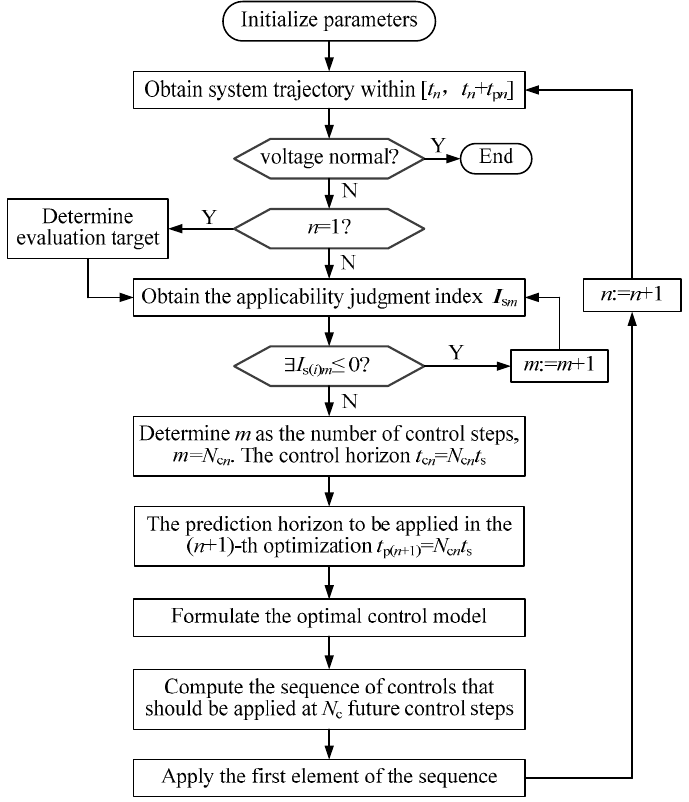
Figure 5. Flow chart for the voltage correction scheme based on AH-MPC.